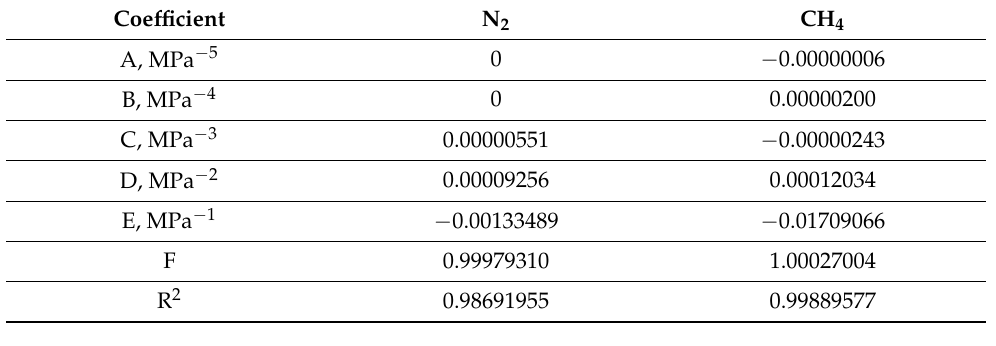
Figure 1. Experimental compressibility factors of ( a ) N 2 data from [15–17], ( b ) CH 4 data from [18–21] and ( c ) Natural Gas data from [20,22–25]. Table 1. Fit coefficients for the calculation of the compressibility factor according to Equation (6) and coefficient of determination (R 2 ) for N 2 and CH 4 according to Figure 1a,b.